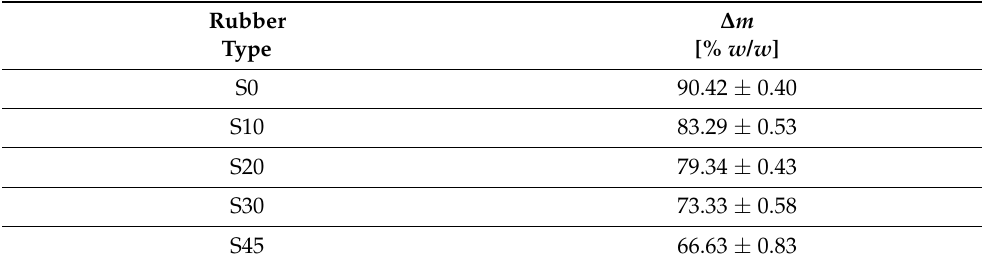
Table 7. Values of weight loss ( ∆ m ) of the investigated rubber composites containing different silica concentrations in the temperature range of 30 to 500 ◦ C as the results of thermogravimetric